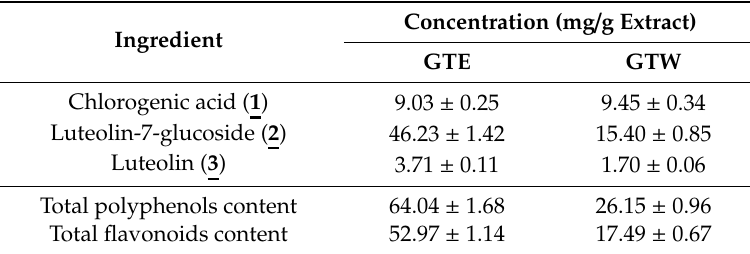
Table 1. Main ingredients analysis of the GT extracts.